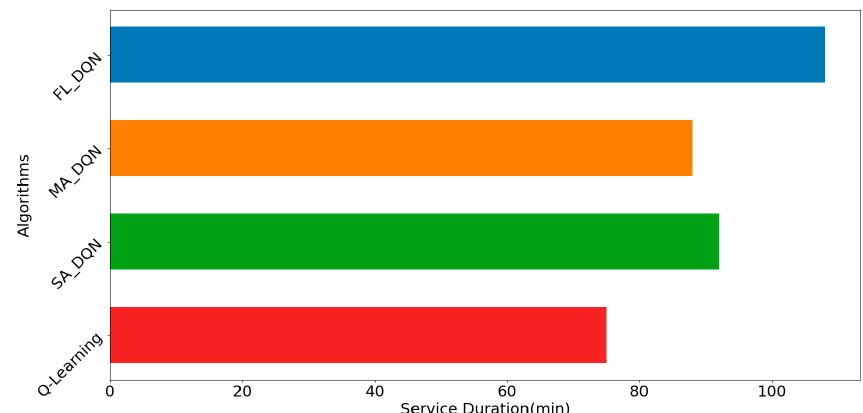
Figure 11. Service duration that can be provided without energy exhaustion.